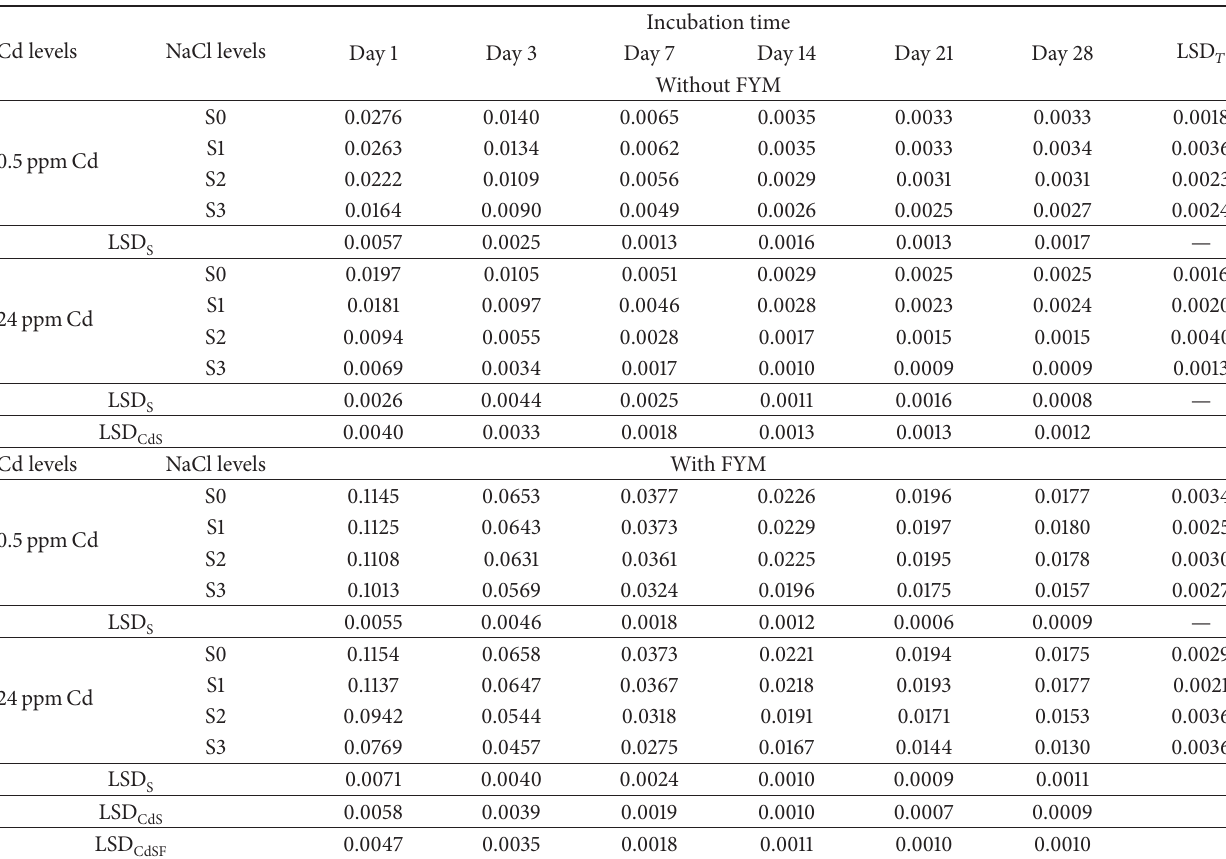
-C evolution rate (mg C g − 1 soil day − 1 ) during incubation time. 2